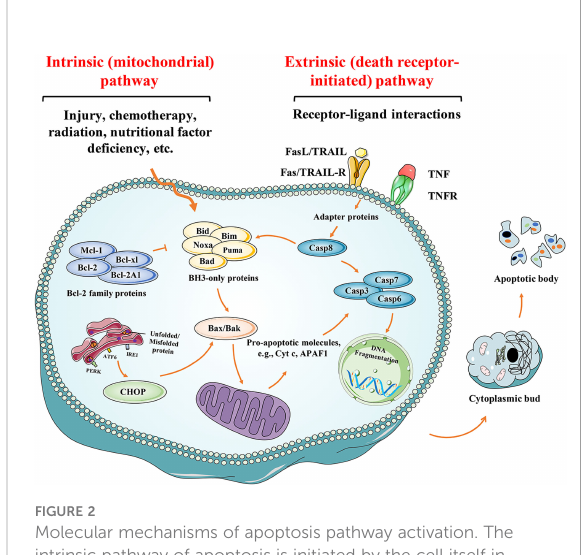
FIGURE 2 Molecular mechanisms of apoptosis pathway activation. The intrinsic pathway of apoptosis is initiated by the cell itself in response to damage, such as injury, chemotherapy, radiation and nutritional factor de fi ciency. Cell stresses engage Bcl-2 homology domain 3 (BH3)-only protein activation, leading to